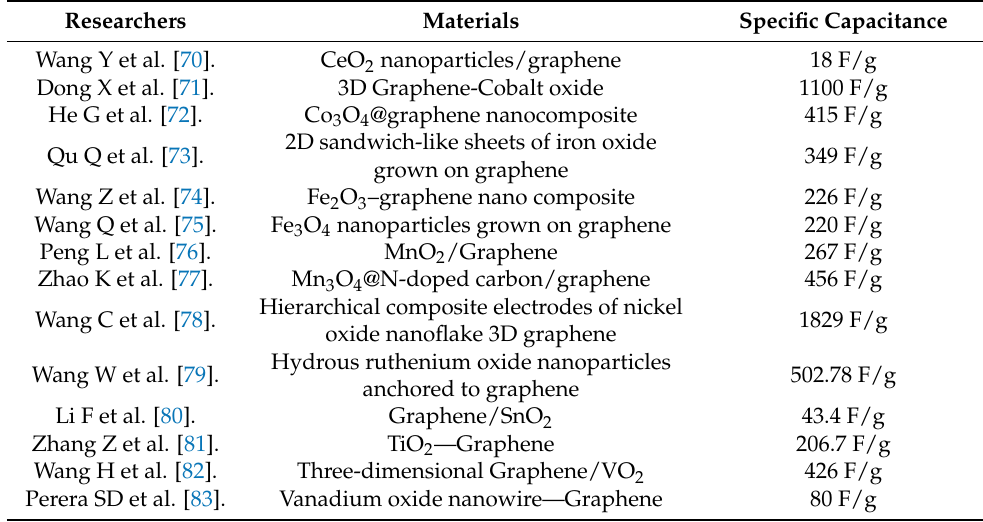
Table 5. Study on the heterozygous structure of metal oxides and